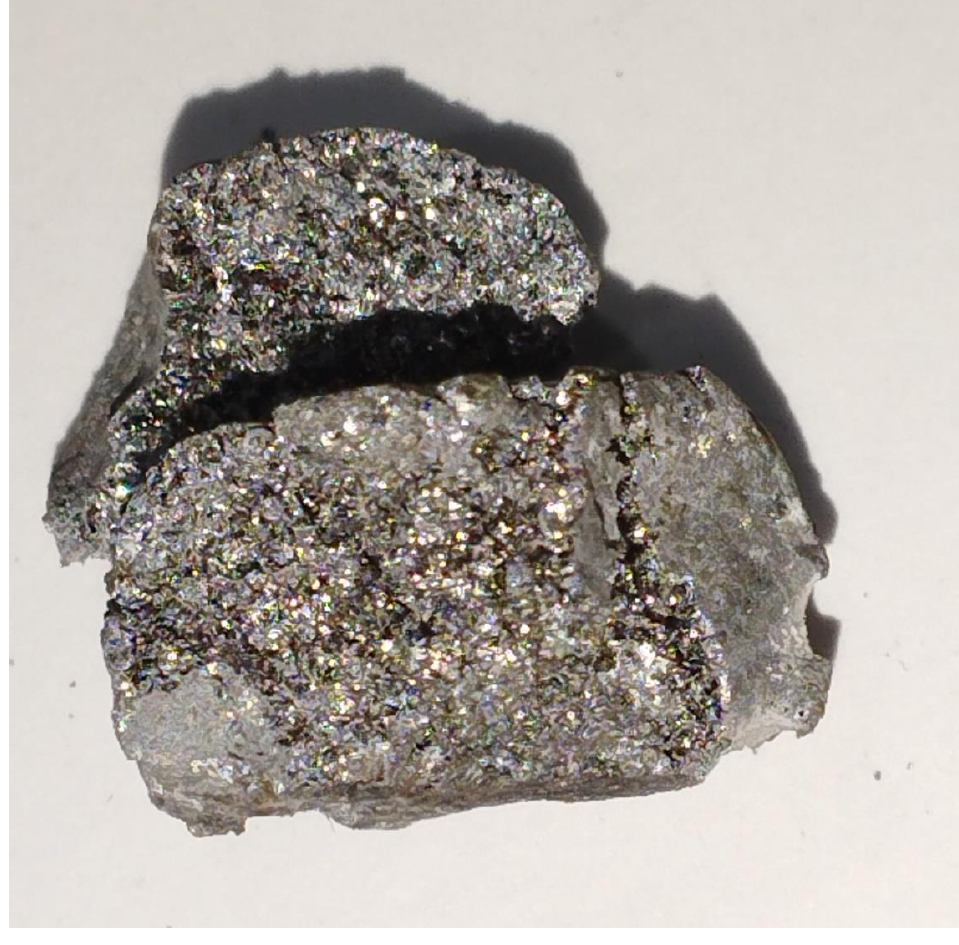
Table 6. Elemental composition of the alloy with various flux additives.